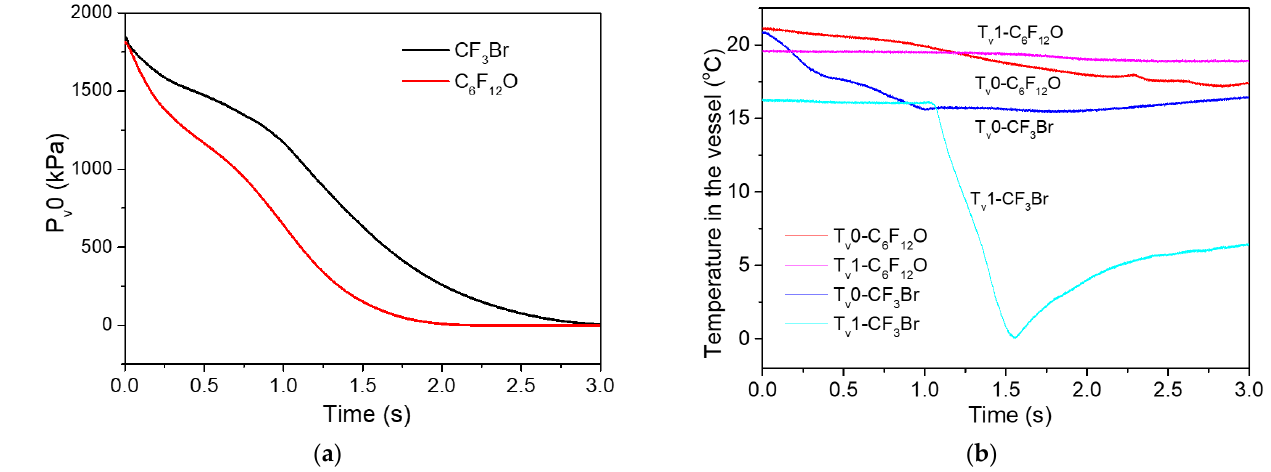
Figure 3. Comparison of the P–T pro fi les in the vessel of the two tests: ( a ) P v 0; ( b ) T v 0 and T v 1.